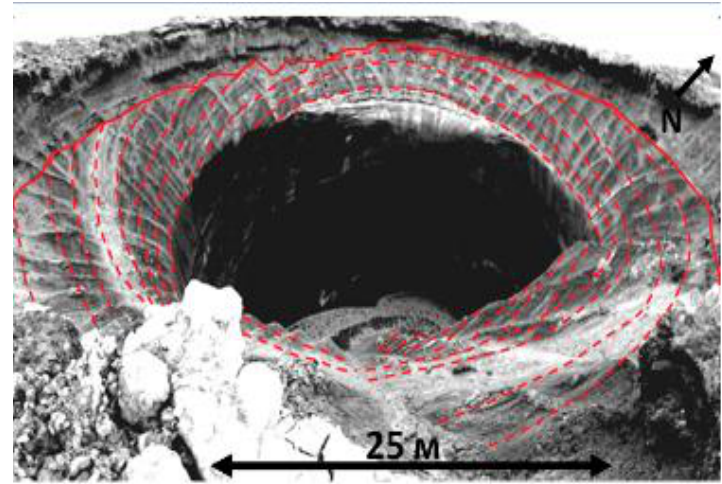
Figure 7. Ring structure (red dotted lines) enclosing the Yamal crater. Designations: the shading indicates the direction of the subvertical layers in the zone adjacent to the crater walls; the solid line marks the lower boundary of the active layer. Photo credit: V.V. Olenchenko.